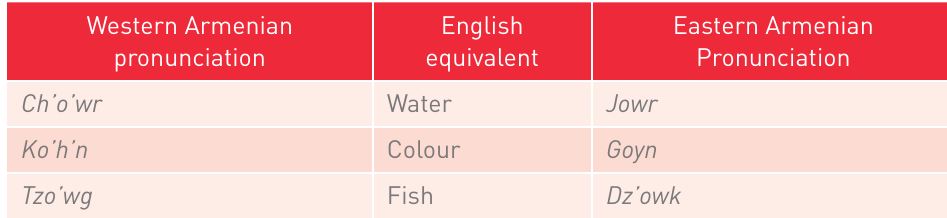
Words with Differing